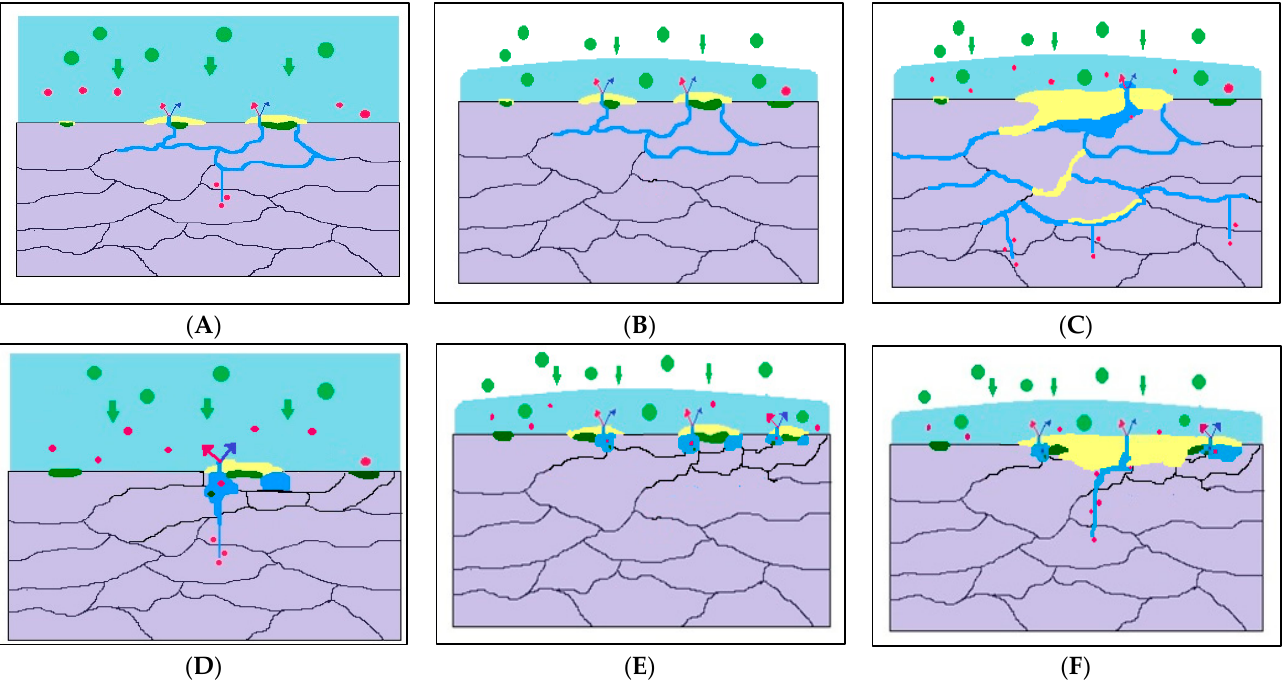
Figure 3. Schematic diagram of the corrosion and SCC processes of Al5083 alloy samples in 3.5 wt% NaCl solution and air environments: ( A ) microcracks are initiated under stress ( B , C ) subsurface attacks develop to a deeper depth ( D ) synergistic effect of stress, anodic dissolution, and hydrogen embrittlement ( E ) accelerates the anodic dissolution of aluminum alloy ( F ) Pitting groups coalesce together to form a larger corrosion site.